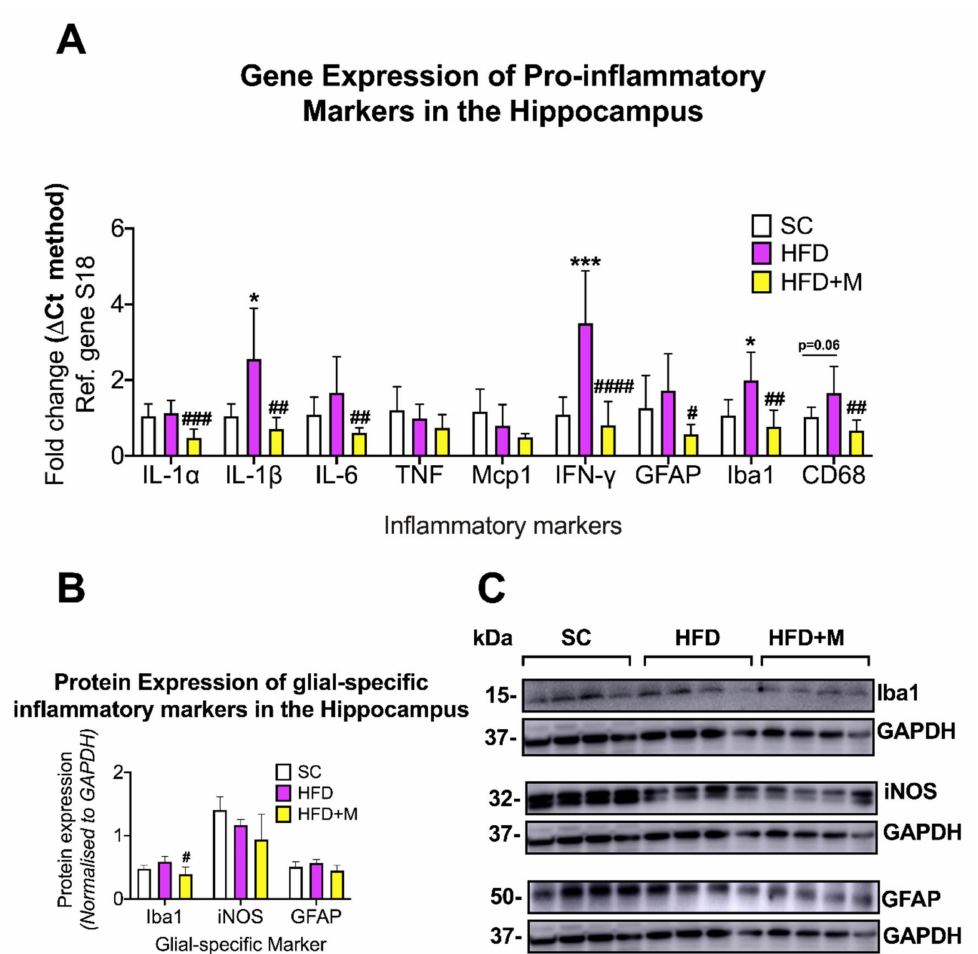
Figure 3. Gene and protein expression analysis of cytokines and glial-specific inflammatory markers in the hippocampus of C57BL/6 mice in response to HFD or metformin administration. Mice were grouped as SC, HFD, and HFD + M. Hippocampi were microdissected from the left and right sides of the brain from all treatment groups and were used for RNA and protein extraction with subsequent quantitative qPCR and Western blotting, respectively. ( A ) Differential gene expression levels of proinflammatory mediators and glial-specific inflammatory markers. ( B ) Protein expression levels of glial-specific inflammatory marker following normalization to the loading control, GAPDH. ( C ) Immunoblot bands for each marker. mRNA levels were quantified using the ∆ Ct method and normalized to the reference gene S18 (housekeeping gene). Data were presented as mean ± S.E.M. * p < 0.05 or *** p < 0.001 vs. SC group; # p < 0.05, ## p < 0.01, ### p < 0.001, or #### p < 0.0001 vs. HFD group as determined by one-way ANOVA followed by Tukey post-hoc test. n = 6–8 per group. Quantification of immunoblot bands was performed using the NIH ImageJ software. Data were given as mean ± S.E.M. # p < 0.05 vs. HFD group as determined by one-way ANOVA followed by Tukey post-hoc test. n = 4 per